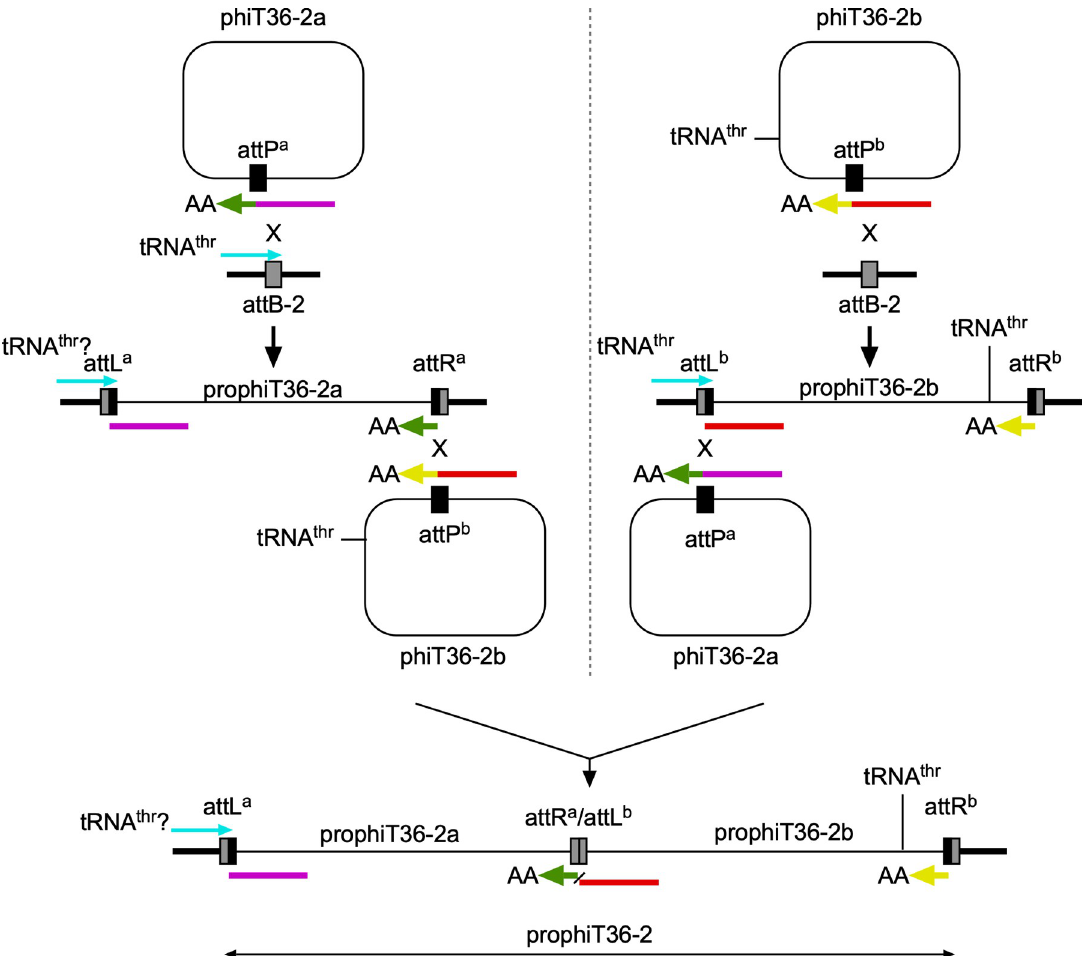
Fig 4. Pathways for formation of tandem prophages in T36. The prophiT36-2 prophage (bottom) is formed by prophiT36-2a (top left) and prophiT36-2b (top right). Both prophages can integrate at the attB -2 site. Additionally, both have integration-dependent immunity systems and the putative repressors for each prophage are not closely related. Formation of prophiT36-2 is likely to have occurred by two sequential site-specific integration events, although the order of events (either side of the dotted horizontal line) is unknown. On the left, an initial event occurs in which phiT36-2a integrates into the attB -2 site to form prophiT36-2a. The attP site ( attP a ) is located within the repressor gene, and the 5’ and 3’ ends of the repressor are shown in purple and green respectively; the extreme C-terminus contains two alanine amino acids (AA) as part of an ssrA-like degradation tag. Integrative recombination results in a stable and active form of the repressor (purple line) at attL a and the 3’ remnant of the repressor gene at attR a . A second integrative recombination even between phiT36-2b and attR a can then give tandem prophages. phiT36-2b also has an attP site within its repressor gene, such that integration results in the 3’ remnant of its repressor at the attR b site and the active form of the repressor at the attR a /attL b junction. Critically, although the att core sequences are closely related to each other, the repressors of phiT36-2a and phiT36-2b are translated in different reading frames, such that the 3’ remnant (green) of phiT36-2a is out of frame with the rest of the phiT36-2b repressor (red). If they were in the same reading frame, and thus fused in-frame at attR a /attL b then the repressor would be unstable and inactive, and the lysogen non-viable. On the right side of the horizontal dotted line is shown an alternative series of events in which the phiT36-2b phage integrates first at attB -2, and then phiT36-2a integrates site-specifically by recombination between attP a and attL b . Also shown is the approximate location of a tRNA thr gene in prophiT36-2b that is absent from other Cluster MabB prophages. Note that the juxtaposition of the repressor and att common core sequences precludes an alternative scenario in which a phage initially integrates to form attL a and attR b followed by homologues recombination between a superinfecting phage and the resident prophage. Sequences of these regions are shown in S2 Fig. The occupied attB -2 sites overlaps a tRNA thr gene (gene t5010 in M . abscessus ATCC19977 [30]), although T36, T38, and T48 are all subspecies massiliense (Table 1), and is used by other MabB prophages for integration, whereas all other MabN phages integrate at attB -13 [30] (Fig